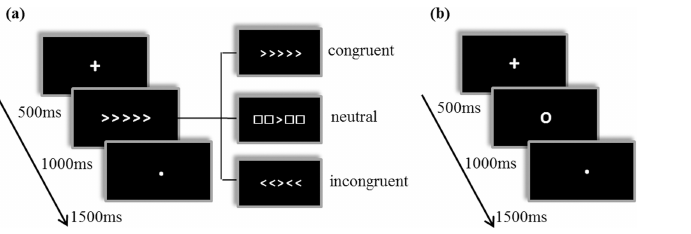
Fig 1. Experimental procedures. (a) The Eriksen flanker task (EFT) procedure; (b) the simple reactiontask (SRT)